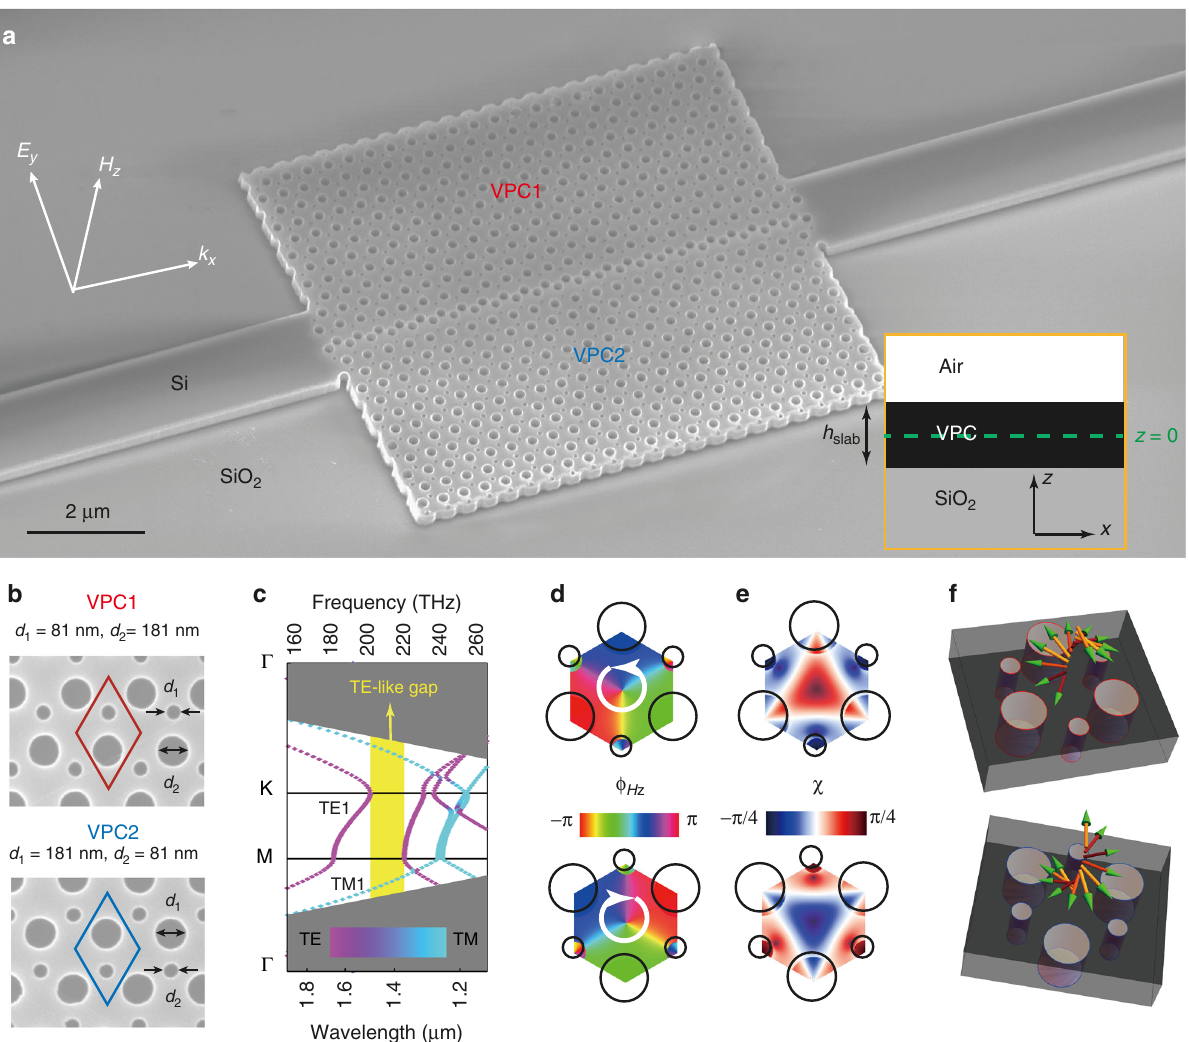
Fig. 1 Band structures and nontrivial topology in silicon-on-insulator (SOI) valley photonic crystals (VPCs). a Oblique-view scanning-electron-microscope image of the fabricated VPC, which is patterned on standard 220-nm-thickness silicon wafer. The VPC is arranged in a honeycomb lattice with a periodicity of a = 385 nm. The inset indicates that the VPC slab is asymmetrically placed between the SiO 2 substrate and the top air region along the z axis. b Details of the unit cells consisting of two inequivalent air holes, i.e., the smaller one with a diameter d 1 ( d 2 ) = 81 nm and the larger one with a diameter d 2 ( d 1 ) = 181 nm for VPC1 (VPC2). c Bulk band both for VPC1 and VPC2. The colormap indicates the linear polarization of a photonic band. There is a 132-nm- bandwidth gap (yellow region) between the fi rst and second TE-like bands (purple) due to the y -axis inversion symmetry broken. Gray region: light cone of silica. d Simulated phase vortex of H z fi eld pro fi le and e ellipticity angle of ( E x , E y ) fi eld at the K valley of the TE1 band for VPC1 and VPC2. The H z phase vortex mainly rotates along the unit cell center, of which the singularity point corresponds to right- or left-handed circular polarization (RCP or LCP). All of the fi eld patterns shown below focus on the z -central plane (labeled as z = 0 in the inset of Fig. 1a). f Temporal evolution of RCP and LCP at the singularity point, respectively. In this work, the refractive index of silicon and silica are n Si = 3.47 and n Silica = 1.45,